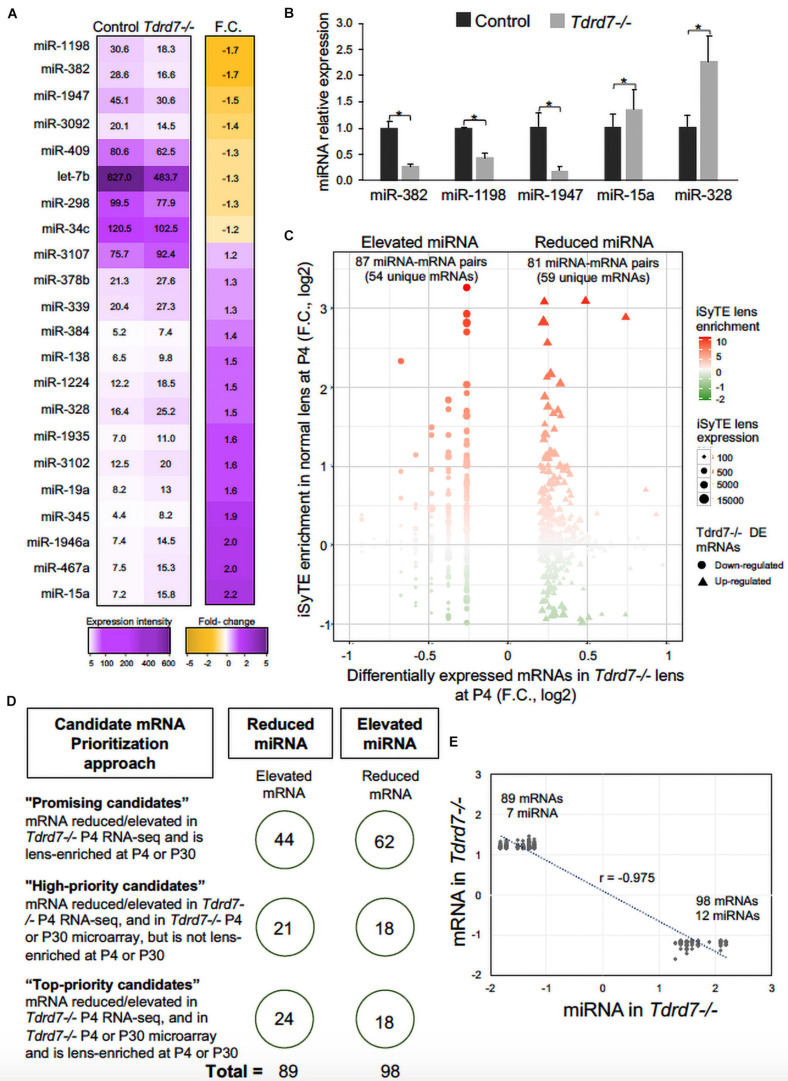
Mis-expression of miRNAs and their mRNA targets in Tdrd7-/- lens. (A) Heat-map represents comparison of miRNA expression in Tdrd7-/- and control lenses (left column) and mis-expression of twenty-two miRNAs (fold change (F.C.) ≥ ± 1.2 fold-change, p < 0.05) in Tdrd7-/- vs. control lenses (right column). (B) Relative miRNA expression in control and Tdrd7-/- lens. qPCR analysis independently validates significant reduction of miRNAs miR382, miR1198 and miR1947, and significant elevation of miRNAs miR15a and miR328. Error bars represents standard error of the mean. Asterisk represents p-value < 0.05. NS represents not significant p-values. (C) Lens-enriched expression of Tdrd7-downstream miRNA target mRNAs. mRNA targets of differentially expressed miRNAs in Tdrd7-/- lens (x-axis) are plotted against iSyTE enrichment scores at P4 (y-axis). Shape gradient represented as circles is for down-regulated mRNAs while triangles represent up-regulated mRNAs. Size gradient represents smaller to higher expression of mRNA. Red and green color gradients represent high and low lens-enrichment, respectively. Similar number of target mRNAs in the Tdrd7-/- lens reduced- and elevated-miRNA group exhibit lens enriched expression at stage P4. (D) Schematic shows candidate mRNA prioritization approach in the Tdrd7-/- lens reduced- and elevated-miRNA group. On the left are shown the rules that were used to prioritize candidate mRNAs in “Top-priority,” “High-priority,” and “Promising” candidate categories. On the right, shown in circles are the numbers of mRNA in the Tdrd7-/- lens reduced- and elevated-miRNA groups. (E) Pearson correlation analysis of miRNA and their target mRNAs identifies inverse correlation (r = -0.975) for the Tdrd7-/- lens reduced- and elevated-miRNA group.